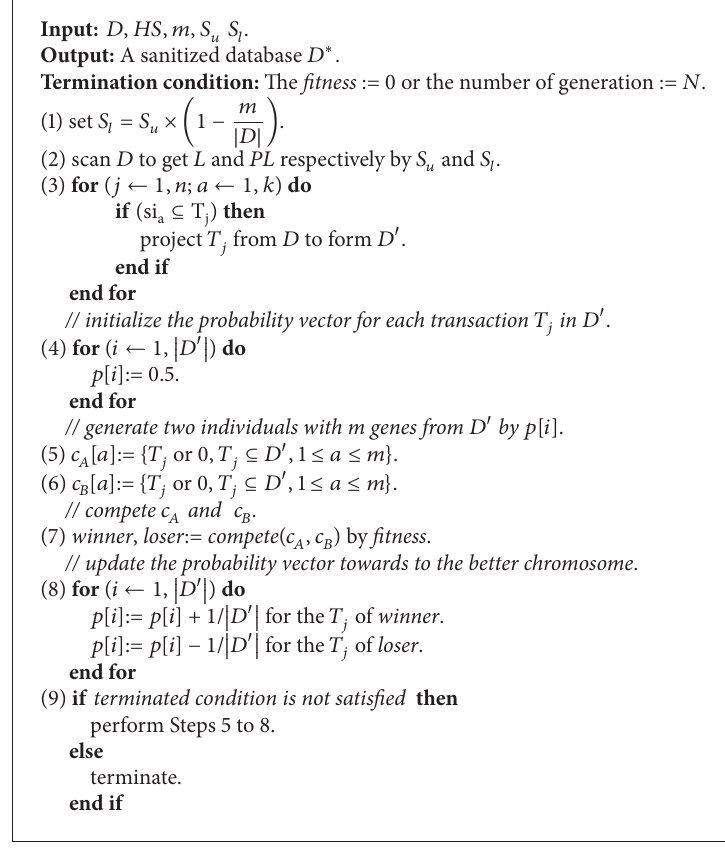
Algorithm 1: cpGA2DT algorithm.